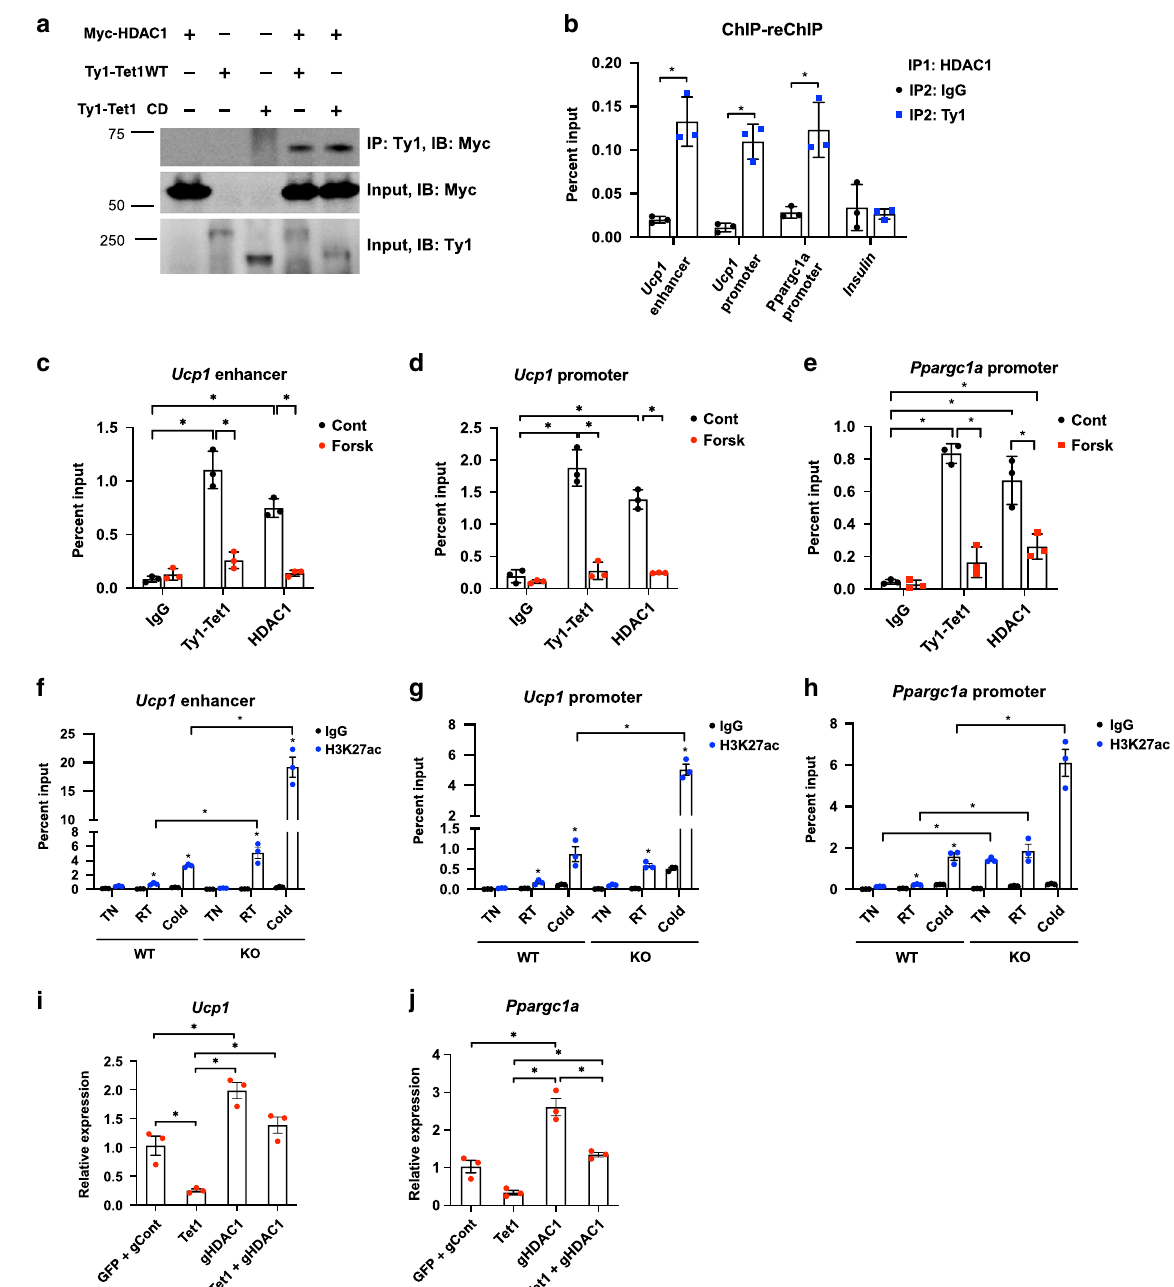
Fig. 7 TET1 coordinates the epigenetic remodeling of the regulatory regions of Ucp1 and Ppargc1a by coordinating with HDAC1. a Co- immunoprecipitation assay was performed using protein lysates from HEK293T cells that were co-transfected with vectors expressing Ty1-Tet1 WT, Ty1- Tet1deltaCD, and Myc-HDAC1. b ChIP-reChIP qPCR analysis was performed on beige adipocytes that were transduced with Ty1-Tet1 WT or GFP using HDAC1 (1st IP), Ty1 (2nd IP), or IgG as a control. The enrichment ef fi ciency is presented as a percent input at the indicated binding sites ( n = 3 per group. Data are expressed as means ± SEM. *denotes p < 0.05, determined by two-tailed Student ’ s t test followed by Bonferroni post-hoc testing). c – e Ty1 and HDAC1 ChIP-qPCR analysis was performed in cells that express Ty1-Tet1 WT with and without forskolin stimulation ( n = 3 per group. Data are expressed as means ± SEM. *denotes p < 0.05, determined by two-tailed Student ’ s t test and two-way ANOVA followed by Bonferroni post-hoc testing). f – h H3K27ac ChIP-qPCR analysis was performed in WT and KO iWAT from RT or exposed to TN or cold for 7 days ( n = 3 per group). Data are expressed as means ± SEM. *denotes p < 0.05, determined by two-tailed Student ’ s t test and two-way ANOVA followed by Bonferroni post-hoc testing. i , j Beige adipocytes were transduced with either Tet1 overexpressor, gRNA against Hdac1 , both, or control plasmids. The forskolin-stimulated level of Ucp1 and Ppargc1a